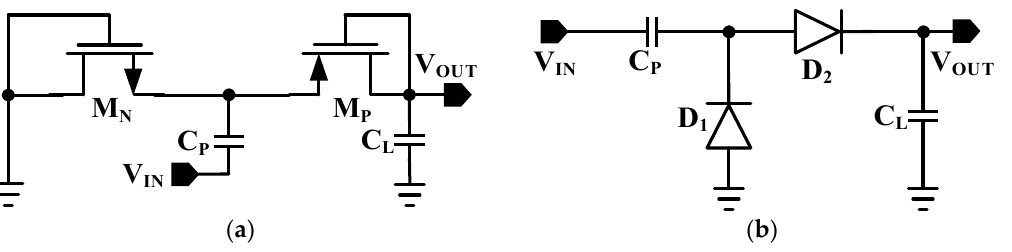
Figure 2. Conventional rectifier design. ( a ) CMOS-based voltage doubler. ( b ) Diode connected volt- age